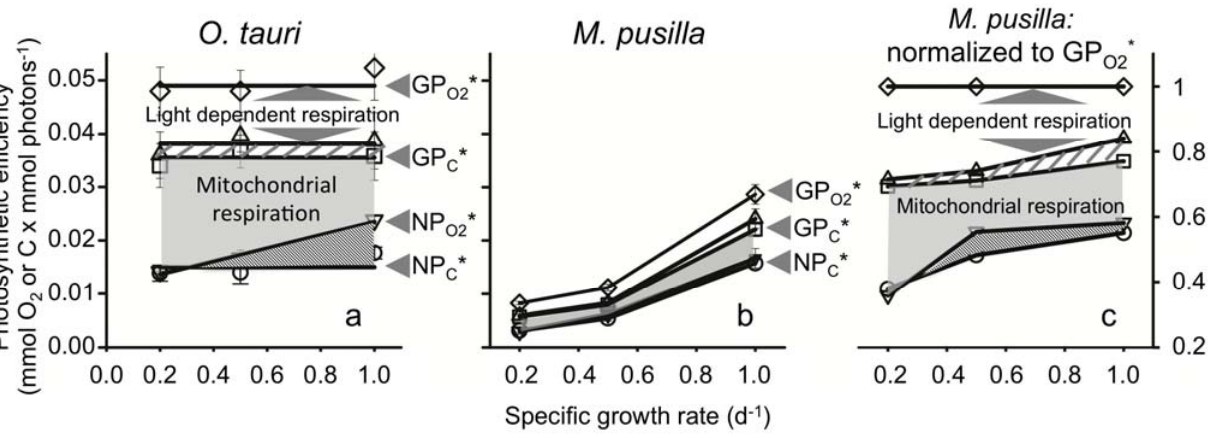
Figure 2. (a) Photosynthetic efficiencies across a wide range of nitrogen limited growth rates in O. tauri and (b) M. pusilla . Normalized to absorbed light, gross O production 2 (GP O2* ;  ), light dependent respiration (GP O2* − LDR * (  )), gross C production (GP C* ;  ), and net C production NP C* ;  ) were independent of growth rate in O. tauri , but increase with growth rate in M. pusilla. Net O production (NP O2* ;  ) increased with growth rate in 2 both strains and distinguishes the amount of transient carbon used for mitochondrial respiration (light grey shaded areas) from transient carbon catabolized for NADPH regeneration (dark grey area). Note that for M. pusilla, NP O2* is only slightly greater than NP C* . (c) M. pusilla production values shown as their fractions of GP O2* demonstrating a similar strategy of energy partitioning between species (compare a and c). The amount of energy dedicated to nitrate and sulfate reduction is indicated in a and c (striped